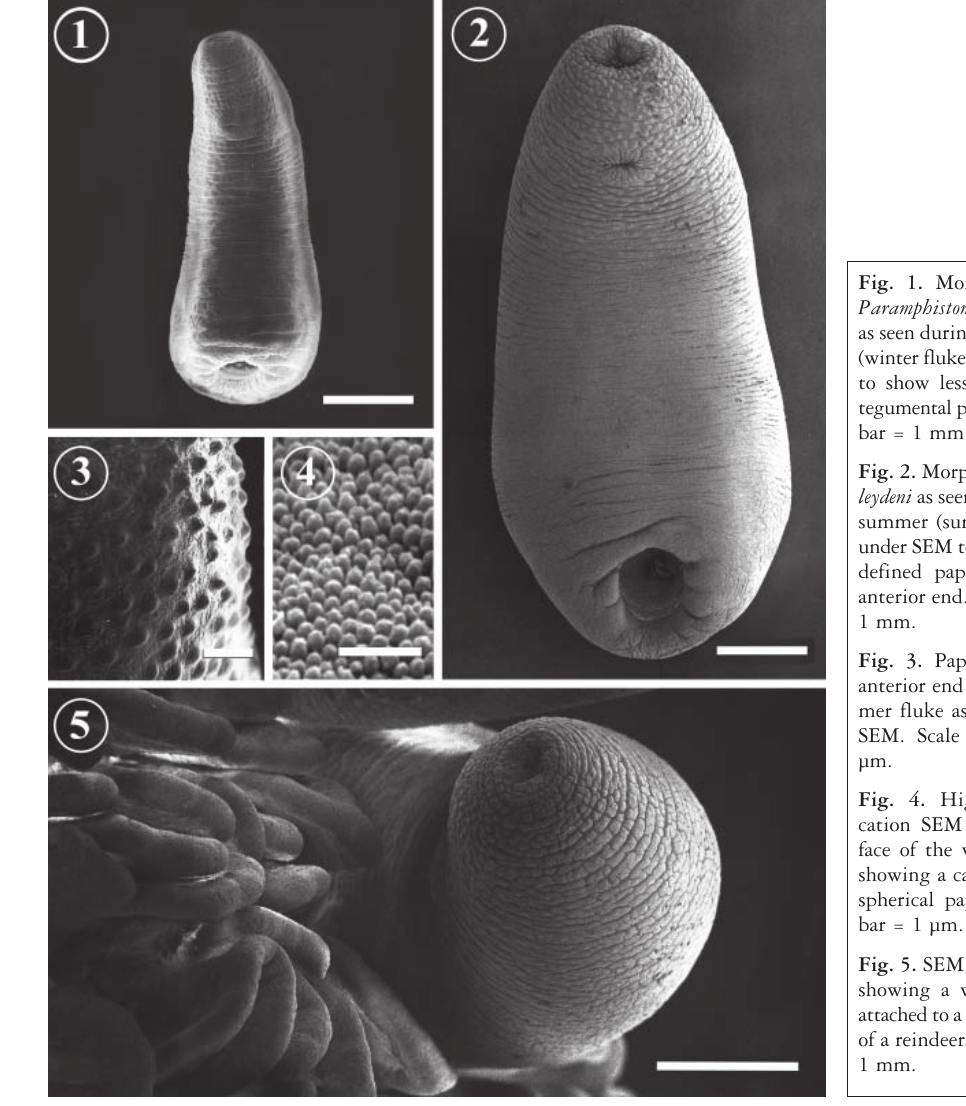
Fig. 1. Morphology of Paramphistomum leydeni as seen during the winter (winter fluke) under SEM to show less prominent tegumental papillae. Scale bar = 1 mm. Fig. 2. Morphology of P. leydeni as seen during the summer (summer fluke) under SEM to show well- defined papillae at the anterior end. Scale bar = 1 mm. Fig. 3. Papillae at the anterior end of the sum- mer fluke as seen under SEM. Scale bar = 100 µm. Fig. 4. High-magnifi- cation SEM of the sur- face of the winter fluke showing a carpet of tiny spherical papillae. Scale bar = 1 µm. Fig. 5. SEM micrograph showing a winter fluke attached to a rumen villus of a reindeer. Scale bar = 1